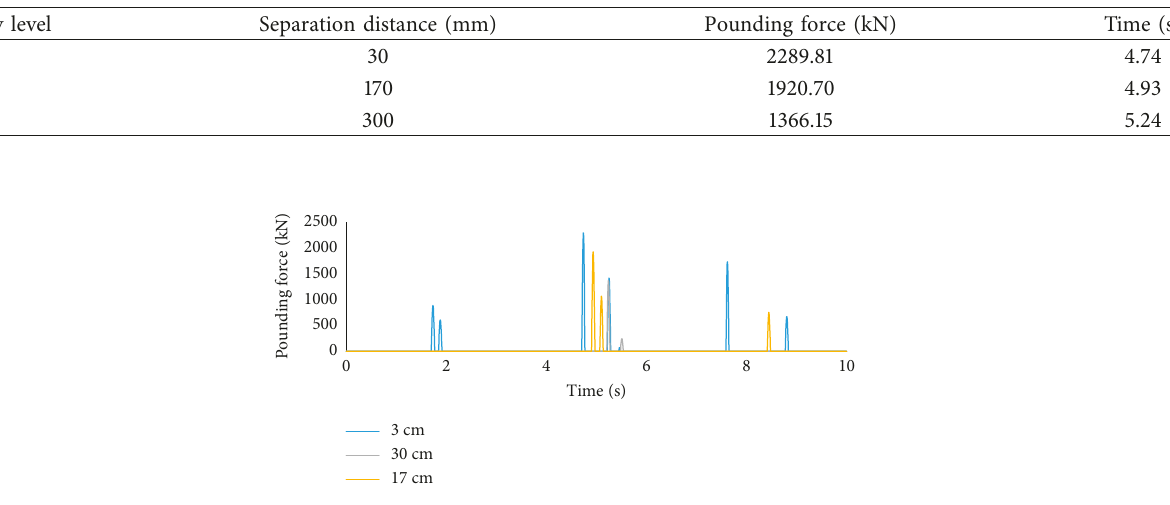
Figure 21: Pounding force considering different seismic